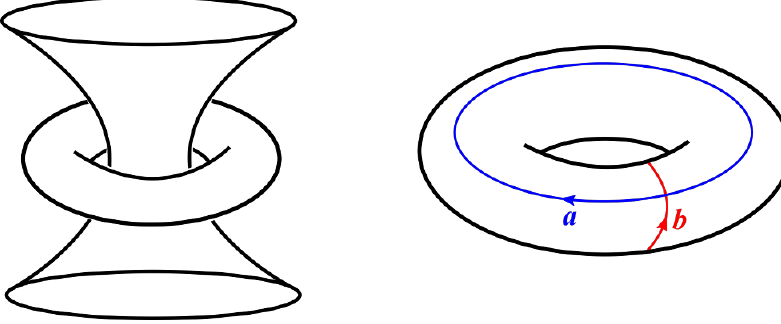
Figure 5 . Heegaard splitting of S 3 into two solid tori shown on the left. The (cid:12)gure on the right shows the two cycles of a torus which form its homology